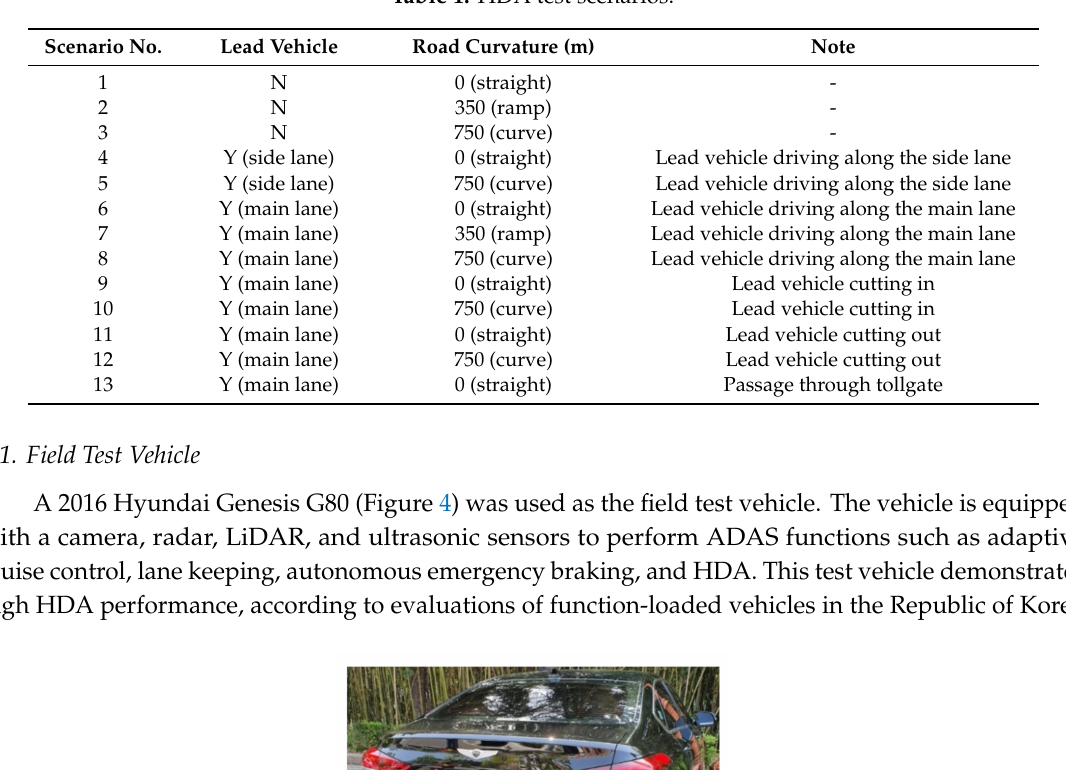
Table 1. HDA test scenarios.